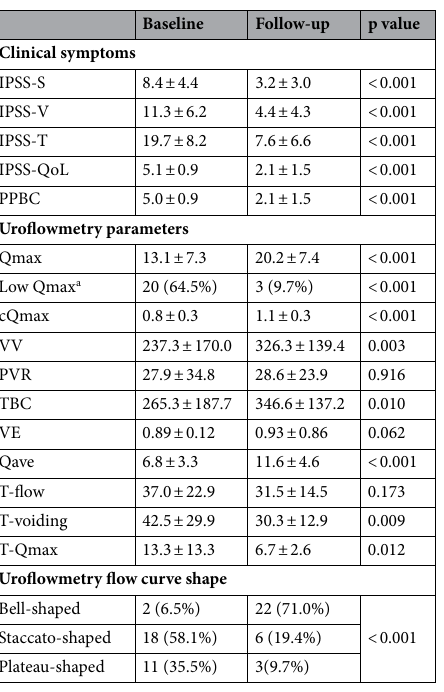
Table 1. Changes of clinical symptoms and uroflowmetry parameters in female DV patients after PFMT at 3-month follow-up. IPSS International Prostate Symptom Score, IPSS-S IPSS storage subscore, IPSS-V IPSS voiding subscore, IPSS-T Total IPSS, IPSS-QoL IPSS quality of life score, PPBC Patient Perception of Bladder Condition, Qmax maximum flow rate, cQmax corrected maximum flow rate, VV voided volume, PVR postvoid residual volume, TBC total bladder capacity, VE voiding efficacy, Qave average flow rate, T-flow flow time, T-voiding voiding time, T-Qmax time to Qmax. a < 12 mL/s or < 15 mL/s for total bladder capacity of 150 mL or 200